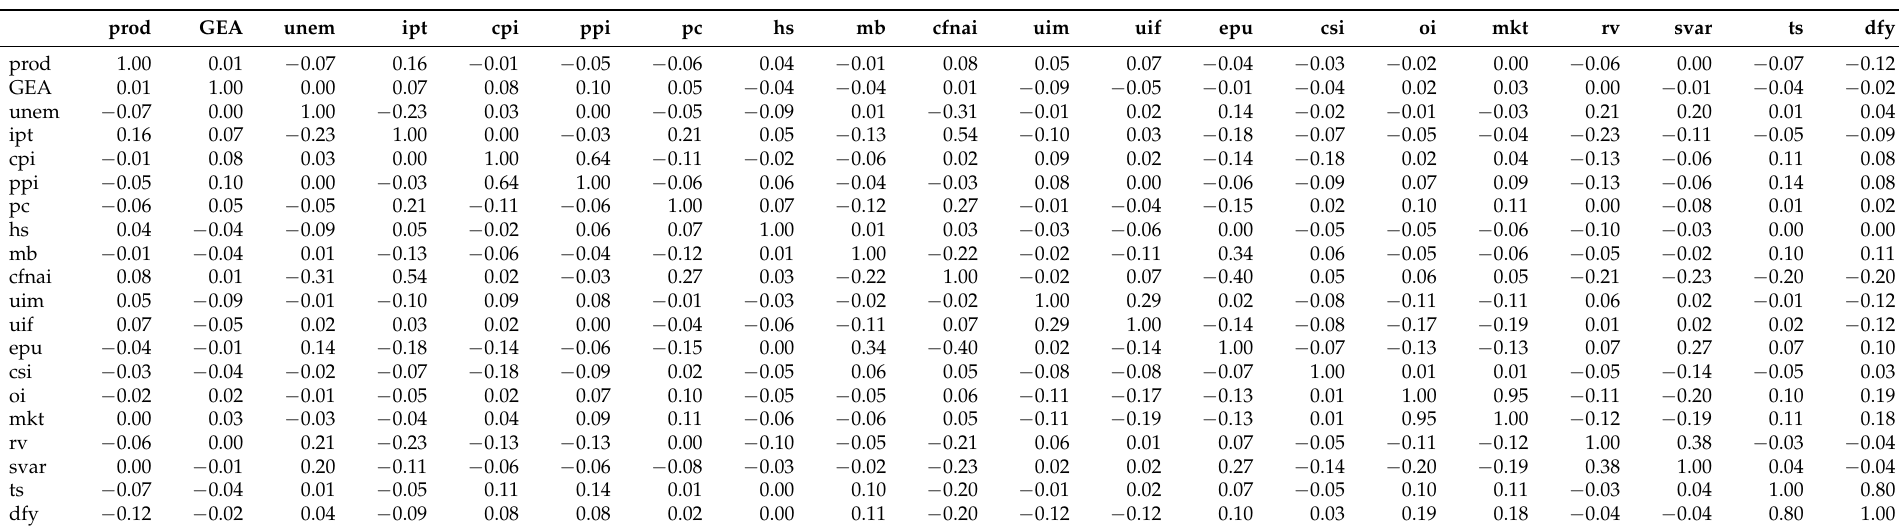
Table 2. Spearman correlation between